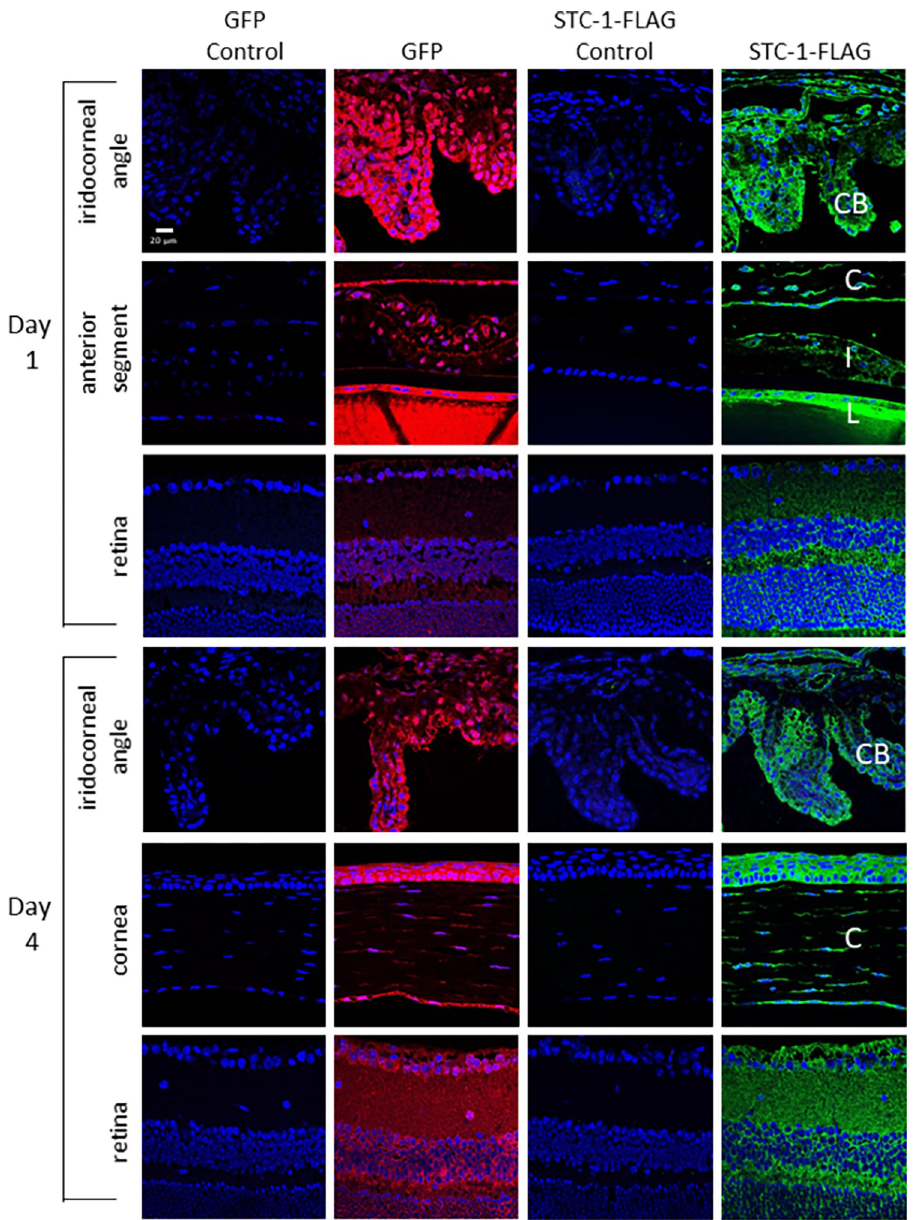
Fig 2. ssAAV2-STC-1-FLAG shows diffuse intraocular expression after intracameral injection. Three-month-old C57BL/6J mice (n = 26) received a single intracameral injection of ssAAV2-STC-1-FLAG in one eye and ssAAV2-GFP in the fellow eye (1 μ L, intracameral injection, 3x10 9 VGs). Diffuse ocular expression was seen following delivery of STC-1-FLAG or GFP with the AAV2 vector. Cells in the iridocorneal angle including ciliary body (CB), anterior segment including cornea (C), iris (I), and lens capsule (L), and the retina showed expression of GFP (red fluorochrome) and STC-1-FLAG (green fluorochrome) at day one post-injection with ssAAV2-GFP and ssAAV2-STC-1-FLAG. Similar results were seen 4 days